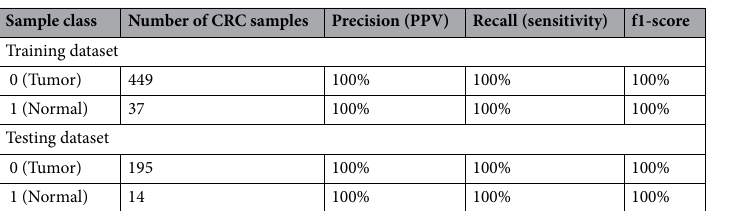
Table 4. Classification performance report of TCGA-CRC dataset on the training and testing dataset with 486 and 209 samples, respectively for the prognostic random forest based ML model. PPV positive predictive value.